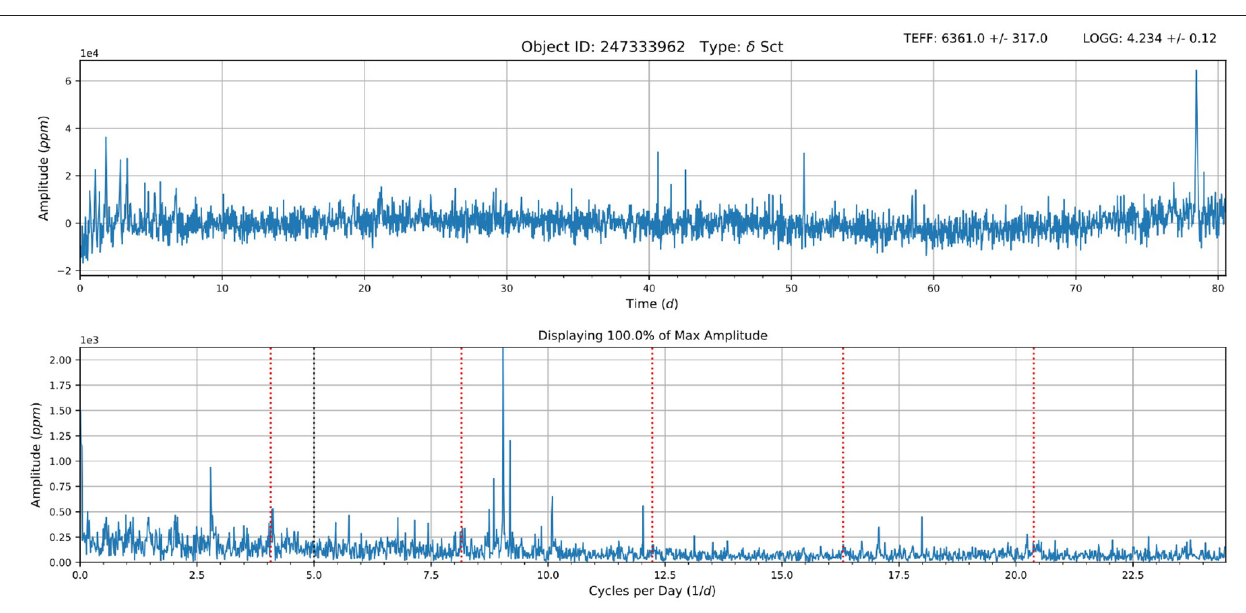
(4.5%). This sample contains stars both on the lower